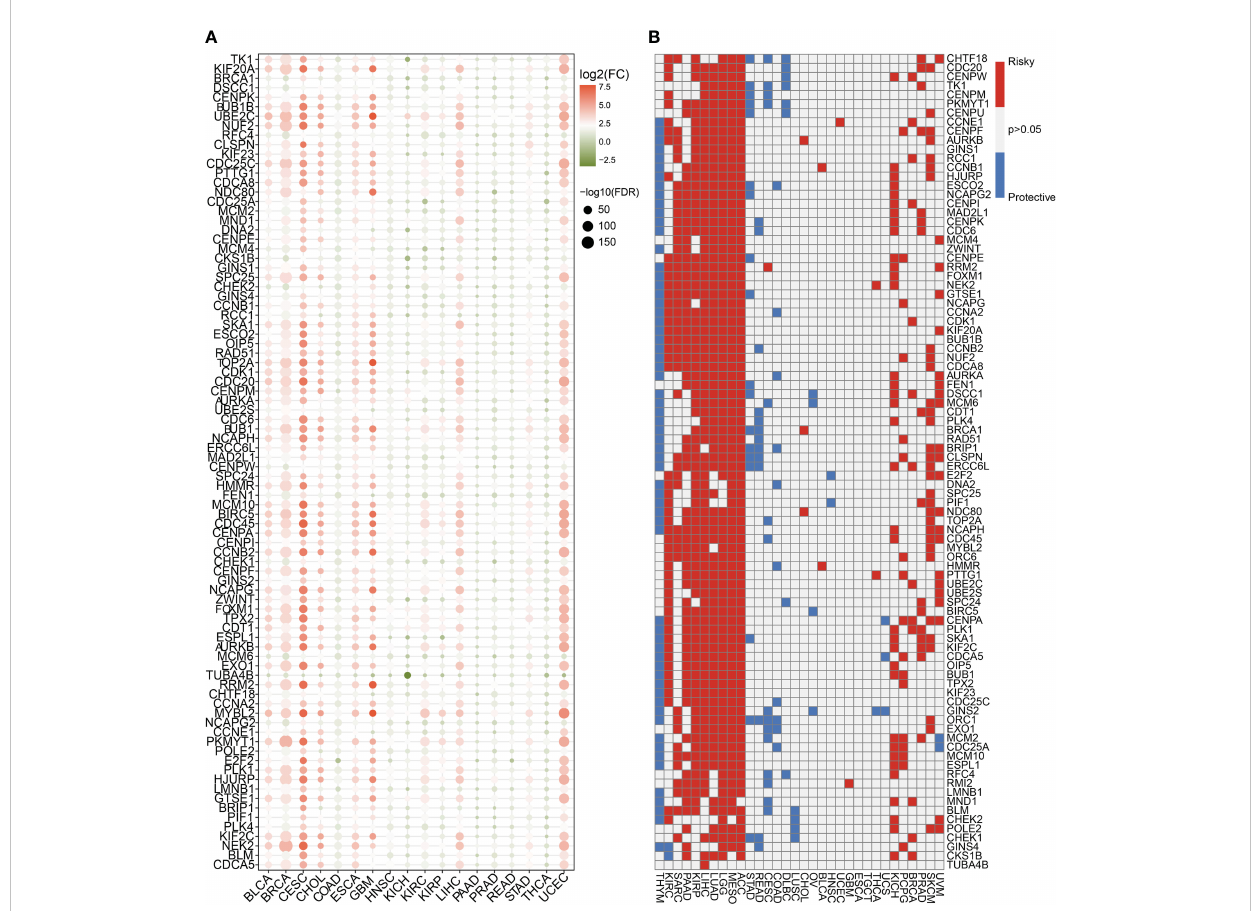
FIGURE 1 Expression traits and prognostic values of the cell cycle-related genes in pan cancer. (A) mRNA expression levels of the 93 cell cycle-related genes in other human tumors (P < 0.05). (B) Clinical outcomes of the cell cycle in pan cancer. White color (P > 0.05) indicates no statistical difference. Red color indicates the risk factor, while the blue color indicates the protective